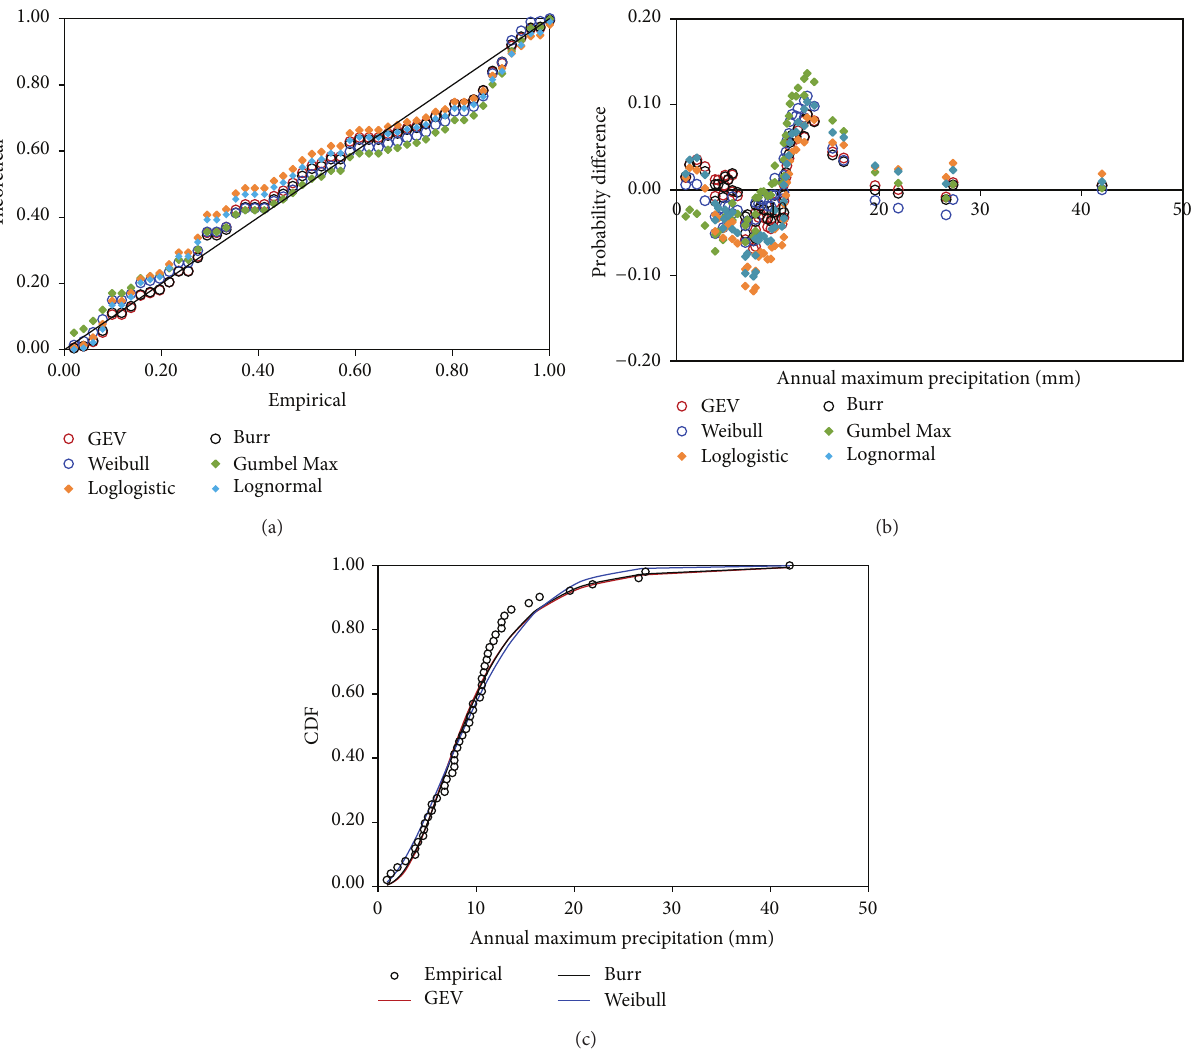
Figure 3: The P-P plot (a), probability difference graph (b), and cdf plot (c) for annual maximum precipitation of EJNQ station by using various probability